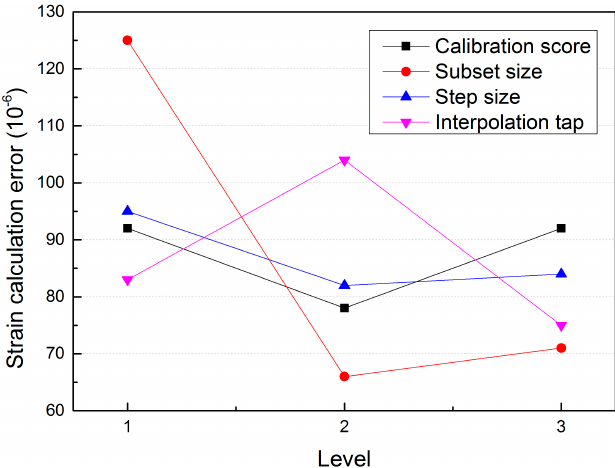
Figure 3. Diagram between levels of factors and strain calculation error. The four lines represent calibration score, subset size, step size and interpolation tap respectively. The optimal level of the three subset levels was 23 pixels (about 5 times the speckle size), the bigger the subset size is, the more information is contained in a single subset and the correlation match is better between the subsets.